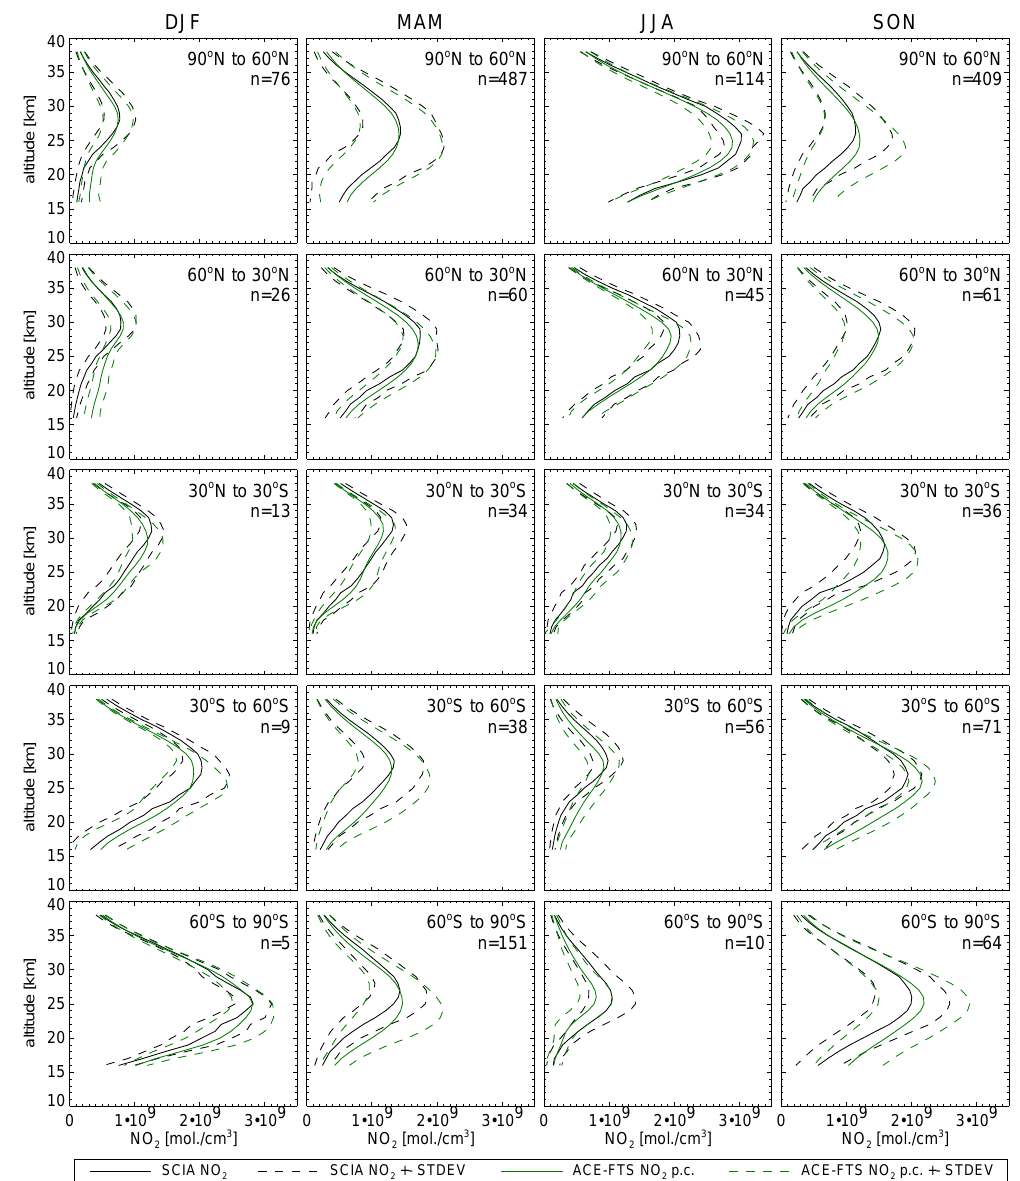
Fig. 15. Same as Fig. 9, but for ACE-FTS. Instead of 2003 and 2004, datasets from 2004 and 2005 are averaged in this figure.